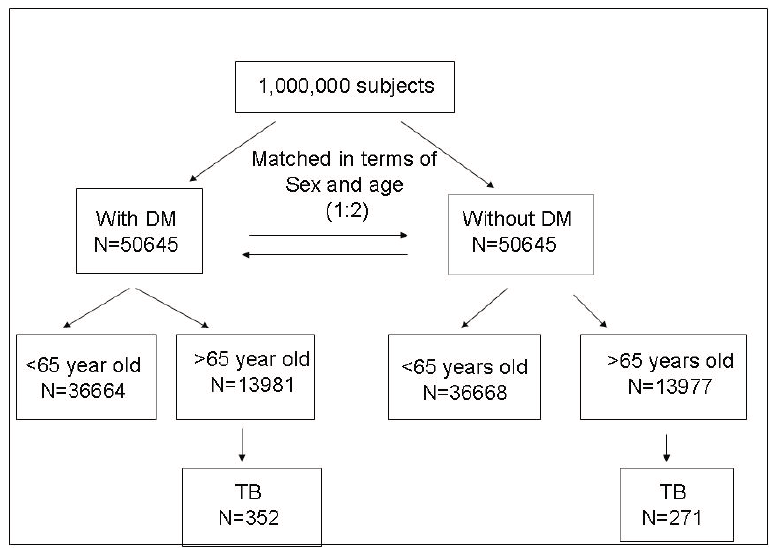
Figure 1. Overall framework of the research design and sampling strategy. DM = diabetes mellitus; TB =